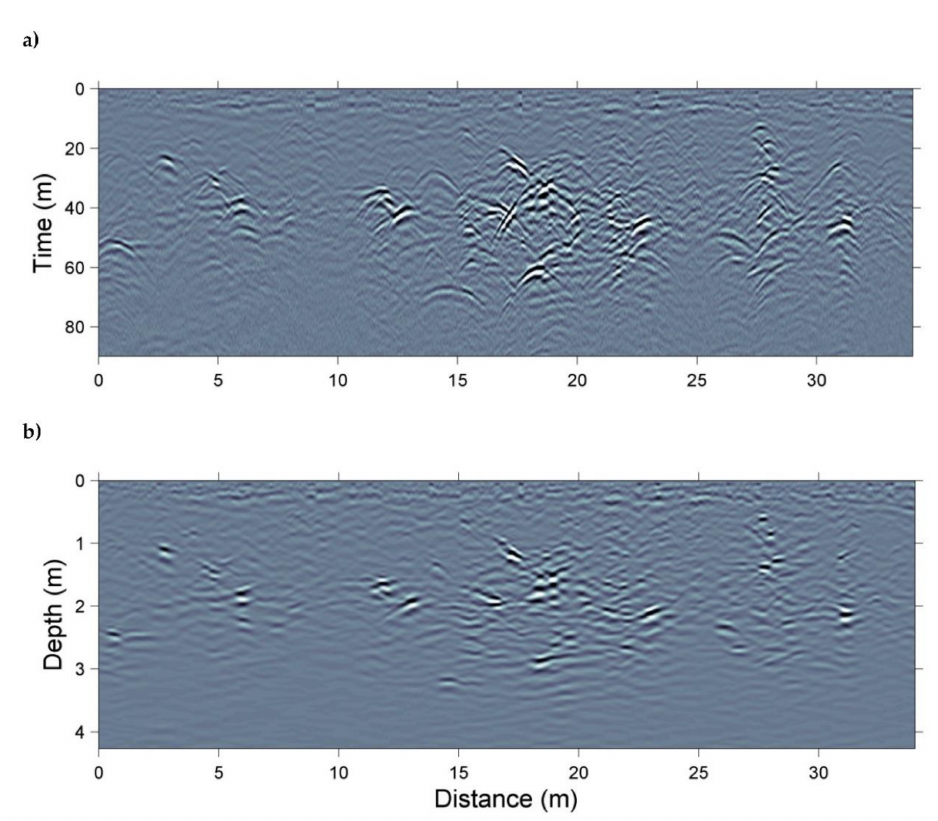
Figure 3. A representative GPR section after initial processing ( a ). The data of this section after multipath summation and depth conversion with V = 0.095 m/ns ( b